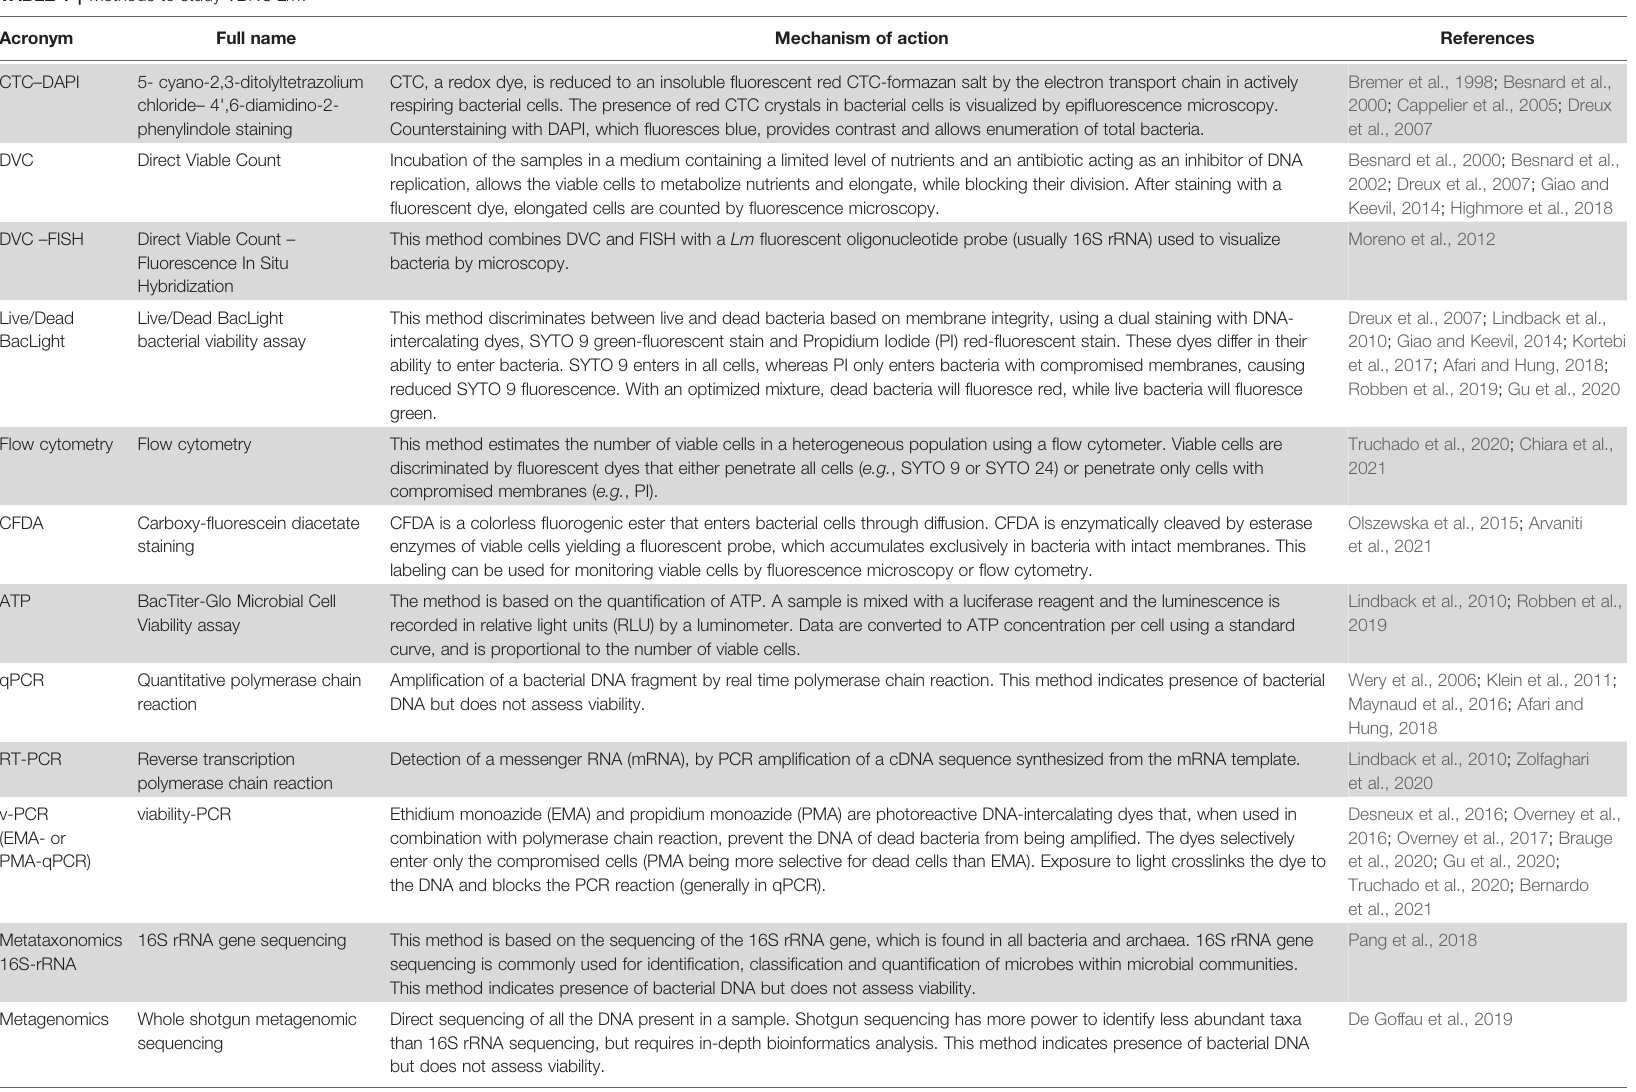
TABLE 1 | Methods to study VBNC Lm